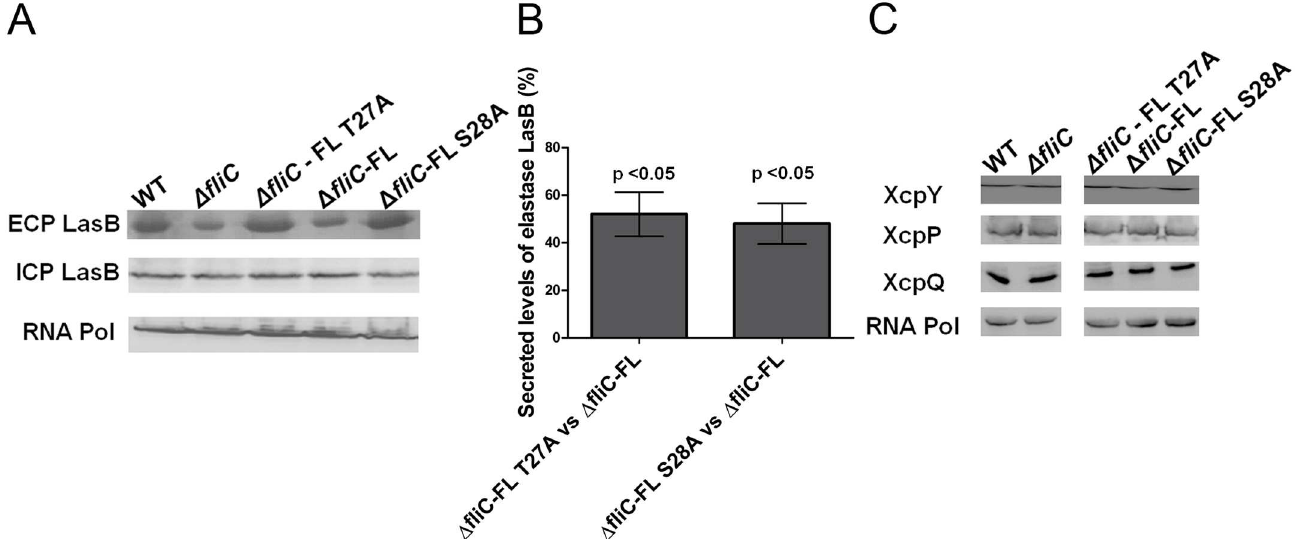
Fig 3. FliC phosphorylation affects T2SS secretion efficiency. (A) Immunoblot of extracellular LasB (top panel), intracellularLasB (middle panel) and intracellularRNA polymerase(RNA Pol) α -subunit (bottom panel) at 13 h for PAO1 WT, Δ fliC , Δ fliC -FL T27A, Δ fliC -FL and Δ fliC -FL S28A strains. Proteins were loadedbased on equal number of cells as shown by RNA Pol α -subunit levels (bottom panel). (B) Quantification of extracellular LasB levels at 13 h in Δ fliC -FL T27A vs. Δ fliC -FL and Δ fliC -FL S28A vs. Δ fliC –FL. Error bars represent mean ± SD calculatedfrom five biologicalreplicates. Student’s t-test p-values < 0.05 for Δ fliC -FL T27A vs. Δ fliC –FL and Δ fliC -FL S28A vs. Δ fliC -FL. (C) Immunoblot of membrane proteins XcpY, XcpP, XcpQ in PAO1 WT, Δ fliC , Δ fliC -FL T27A, Δ fliC -FL and Δ fliC -FL S28A strains at 13 h. The proteins were loadedfrom equal number of bacterial cells as shown by immunoblotting of RNA Pol α -subunit